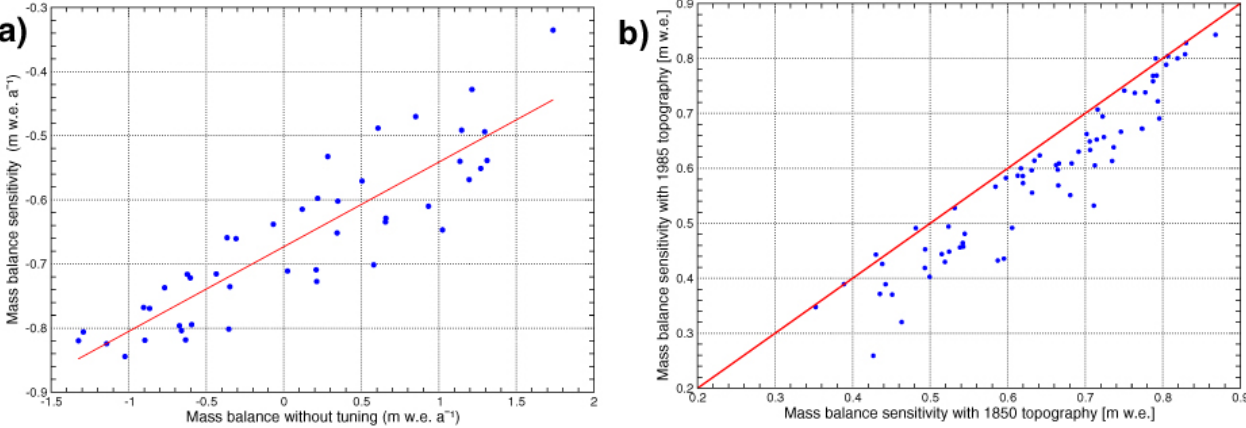
Fig. 7. (a) Comparison of the mean mass balance from the reference run without tuning (AR) with the mass balance sensitivity starting from a tuned zero balance (AS). (b) Scatter plot comparing the mass balance sensitivity for the 1850 DEM and glacier extent with the sensitivity for the 1973 extent and the 1985 DEM (sensitivity runs AS and